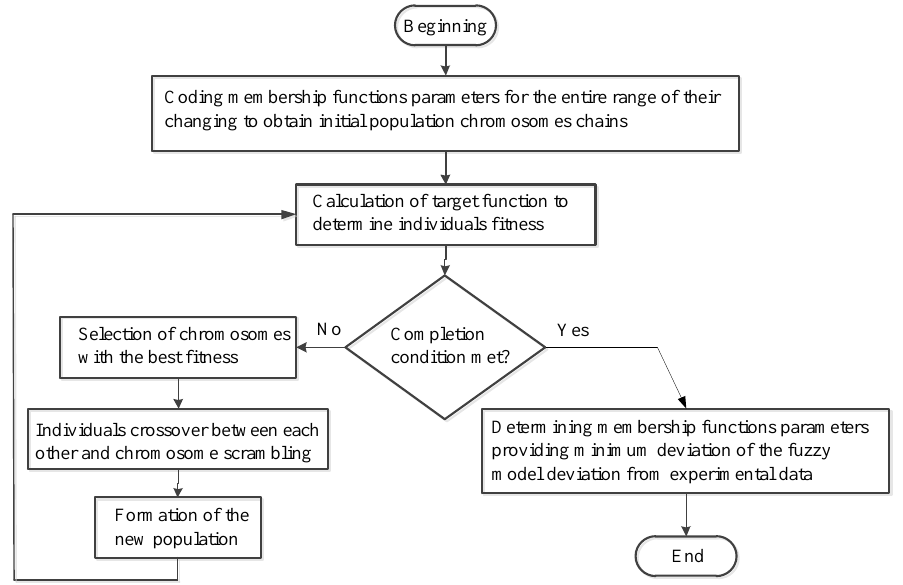
Figure 6. Block schematic diagram of the classical GA applied to the problem of optimization of the membership function parameters of the DG plant element fuzzy model.